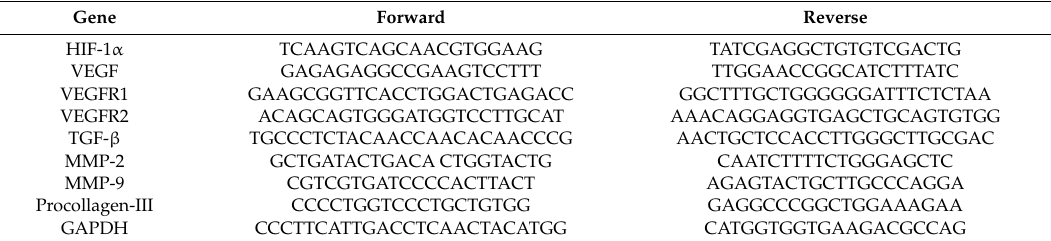
Table 1. Primer sequences used for quantitative real-time PCR